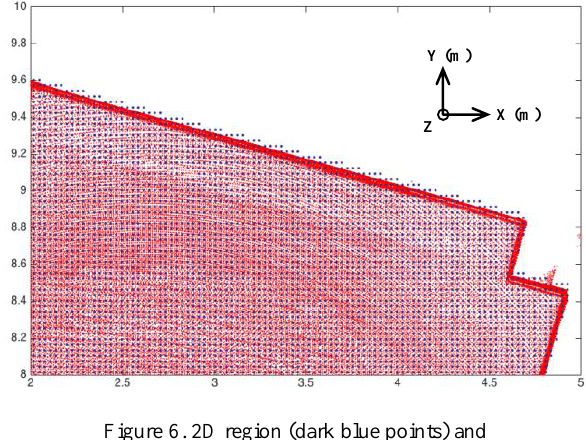
Figure 6. 2D region (dark blue points) and floor points projected in 2D (red points) Note that 3D regions are created based on a floor point cloud resampled at 5 cm. This sampling is required for the next step namely plane segmentation. After distances computations and attribution of points to regions, some points are still not assigned to a region. These points, which notably correspond to openings, will be exploited in the